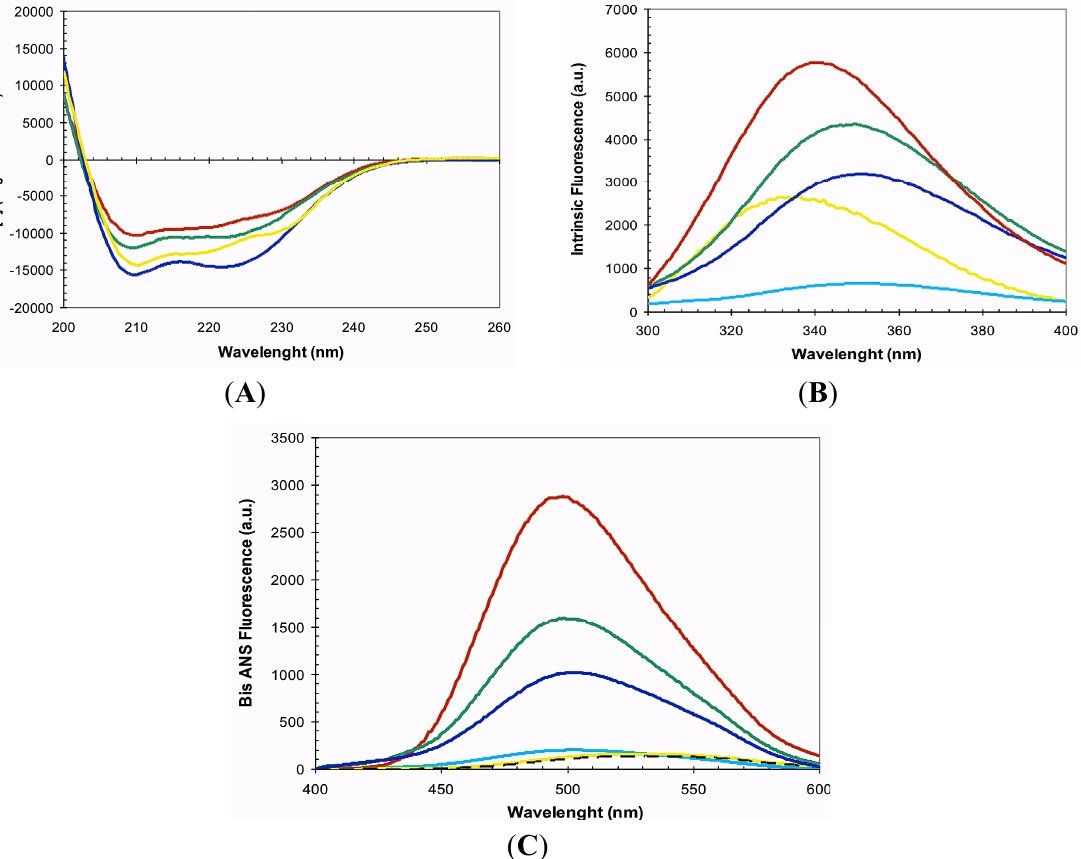
4,4'-Dianilino-1,1'-Binaphthyl-5,5'-Disulfonic Acid (bis-ANS) fluorescence at 25 °C.